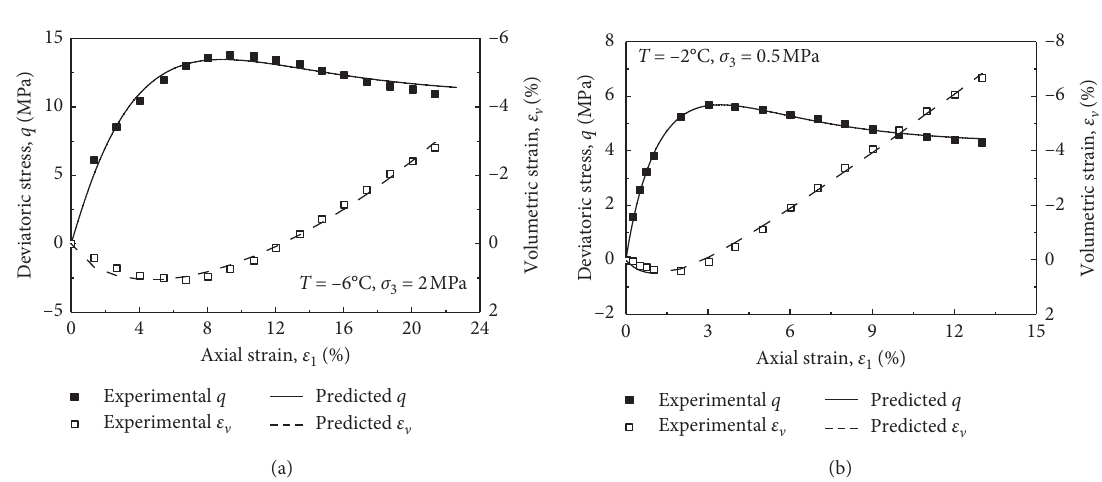
Figure 15: Predicted and experimental results of frozen soils in previous studies: (a) frozen saline sandy soil [12]; (b) frozen standard sand